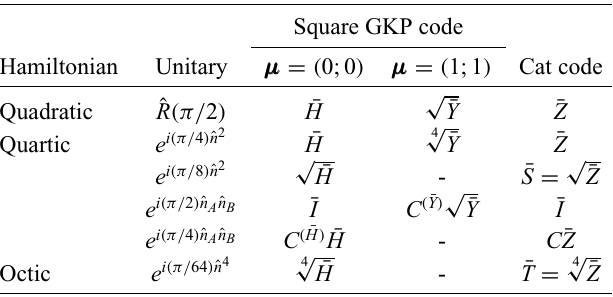
TABLE III. Comparison of gates in the GKP square code and √ ¯ Y = exp { i (π/ 8 ) [3 ( ¯ Y + the four-legged cat state. The gate C ( ¯ Y ) A ¯ Y ¯ Y ) + 5 ( ¯ I + ¯ Y ) ] } corresponds to the equivalent of a B A B controlled-phase gate in the ¯ Y basis, and the gate C ( ¯ H ) ¯ H = exp { i (π/ 4 )( 3 + ¯ H A + ¯ H B + 3 ¯ H A ¯ H B ) } corresponds to the